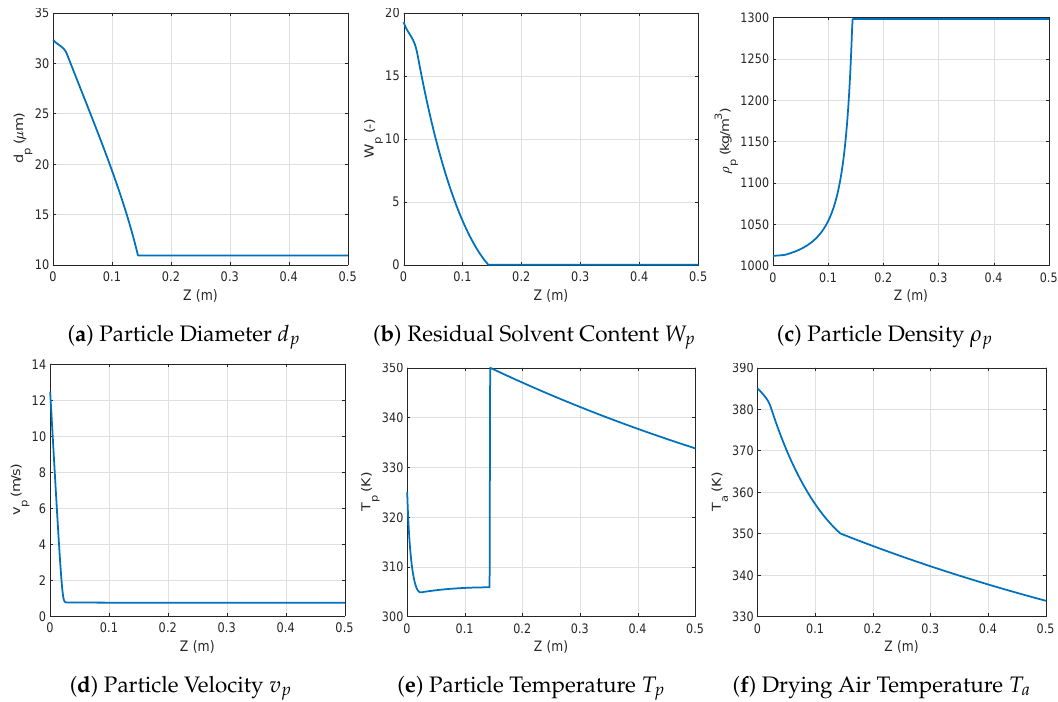
Figure 2. Example of the spray drying output evolution along the length of the drying chamber at nominal